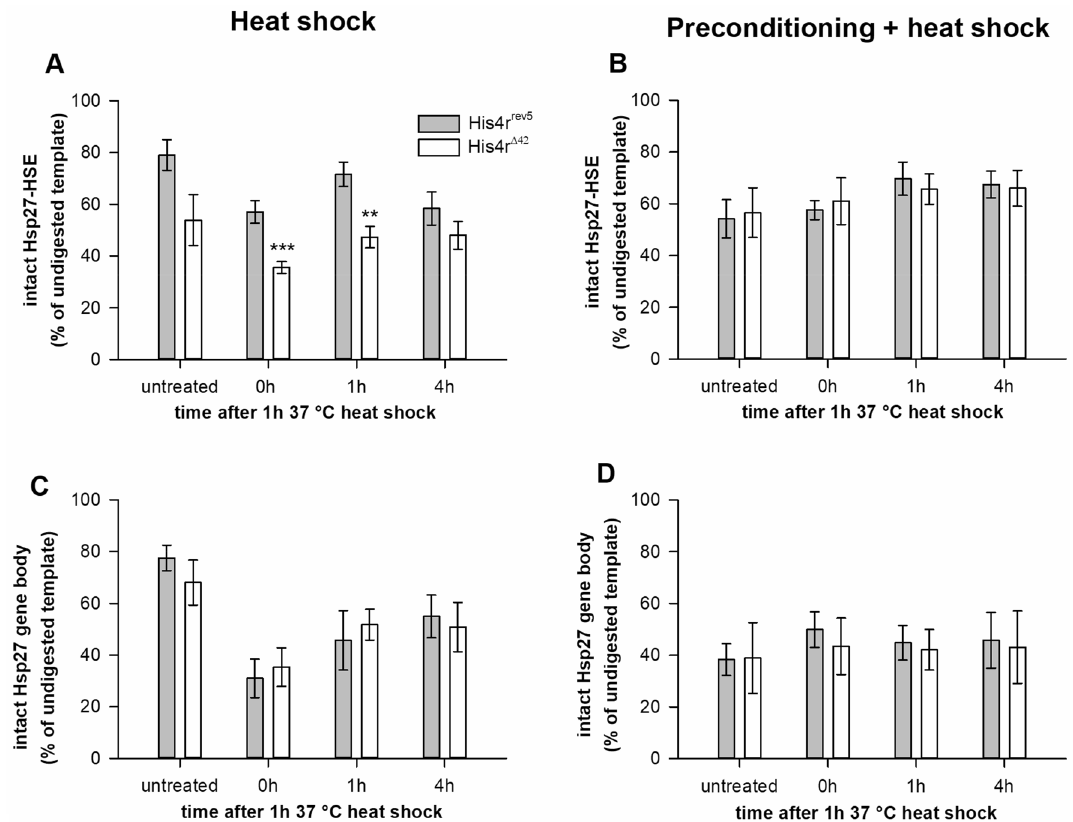
Figure 7. His4r is a component of chromatin at the HSE containing regulatory region of Hsp27 . (A) In His4r mutants (white) lower amount of intact Hsp27-HSE was present after MNase digestion even without heat shock treatment compared to the controls, although this difference was not significant. Following heat shock significantly less PCR products were detected in His4r Δ42 flies than in controls indicating more open chromatin.in the absence of His4r. (B) After preconditioning for 2 days in the controls the amount of intact Hsp27-HSE was reduced to the levels of His4r mutants cancelling out the difference between the two genotypes, furthermore, heat shock did not result in further chromatin opening. Chromatin accessibility at the gene body of Hsp27 in heat shock experiments without preconditioning (C) or with preconditioning (D) did not differ between His4r mutants and controls. **P < 10 −2 , ***P < 10 −3 , in the previous experiments. In these experiments loss of nucleosomes allows the access of MNase to DNA that leads to less PCR products while the presence of intact nucleosomes protect DNA from MNase digestion and leads to more PCR products. 37 °C heat shock induced loss of nucleosomes both at the HSE containing regula- tory region ( His4r rev5 P = 0.01199; His4r Δ42 P = 0.0375, t-test) (Fig. 7A) and at the gene body ( His4r rev5 P = 0.00098; His4r Δ42 P = 0.02244, t-test) (Fig. 7C) that was detected by lower amount of intact DNA sequences after MNase treatment. In His4r Δ42 samples we measured lower amount of intact Hsp27-HSE elements after MNase digestion than in His4r rev5 controls even before heat shock treatment, however this difference was not significant (P = 0.07714, t-test) (Fig. 7A). Immediately after the 1-h 37 °C heat shock treatment significantly less PCR product was detected in His4r Δ42 flies compared to the His4r rev5 controls (P = 0.00053, t-test) (Fig. 7A) indicating that the chromatin structure of the Hsp27-HSE site was more accessible in the mutant. The amount of intact Hsp27-HSE templates in His4r Δ42 remains significantly lower (P = 0.0022, t-test) than in controls 1 h after the heat shock (Fig. 7A), however, this difference levels off 4 h after heat shock treatment (Fig. 7A). When we preconditioned His4r Δ42 and His4r rev5 flies for 2 days at 34 °C we observed similar quantities of Hsp27-HSE specific PCR amplicons before heat shock in both genotypes (Fig. 7B) as in His4r Δ42 flies without preconditioning (Fig. 7A). This result indicates that preconditioning relaxed chromatin at the HSEs in the control while did not have an effect in the His4r mutant. Furthermore, preconditioning before heat shock treatment abolished the difference in the amount of intact HSP27- HSE elements between His4r Δ42 and His4r rev5 controls at all inspected time points (Fig. 7B) similarly to what we ences chromatin accessibility at the gene body we performed qPCRs on the same samples using Hsp27 coding sequence specific primers. Our results show that in heat shock experiments there is no difference in the accessibil- ity of chromatin at the Hsp27 gene body between His4r Δ42 mutants and His4r rev5 controls neither without (Fig. 7C) or with preconditioning (Fig. 7D). This suggests that while His4r is a significant component of chromatin at the regulatory region of Hsp27 it does not play an important role at the gene body.